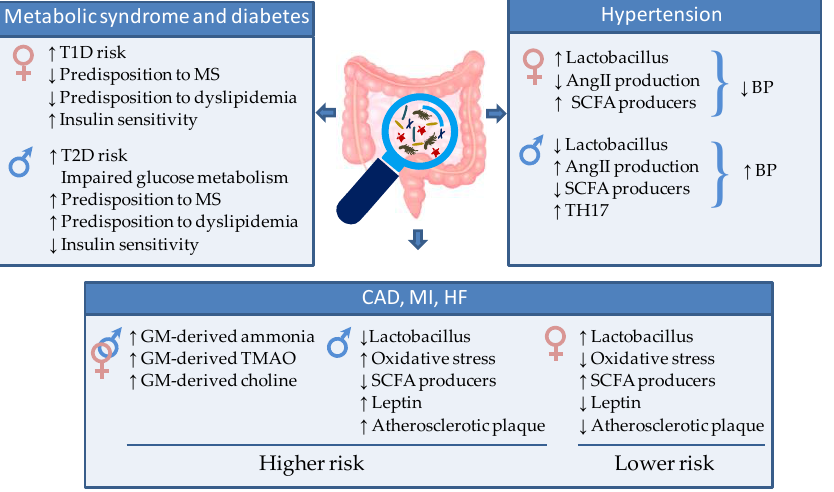
Figure 3. Schematic representation of the gut microbiota-mediated sex differences in CM and CV risk and disease. AngII = Angiotensin 2. SCFA = short chain fatty acid, TH17 = T helper 17 cells, TMAO = Trimethylamine/trimethylamine N-oxide, T1D = type 1 diabetes, T2D= type 2 diabetes.